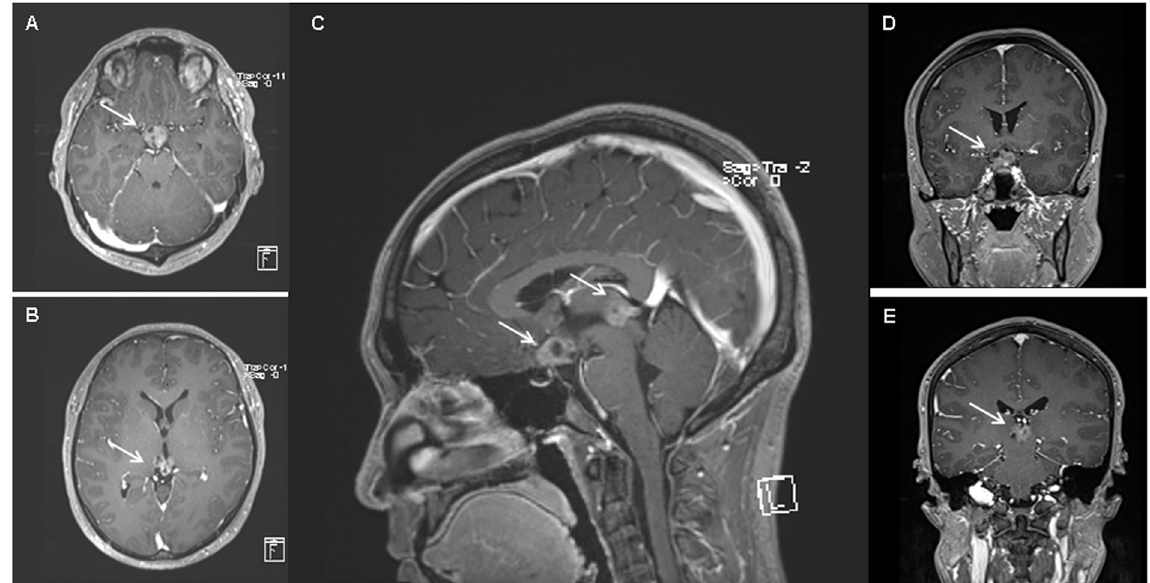
Fig 1. A case of bifocal germinoma at diagnosis. (a) Suprasellar lesion (white arrow) on MRI T1 gadolinium axial image. (b) Pineal lesion (white arrow) on MRI T1 gadolinium axial image. (c) Bifocal lesions (white arrows) on MRI T1 gadolinium sagittal image. (d) Suprasellar lesion (white arrow) on MRI T1 gadolinium coronal image; E) Pineal lesion (white arrow) on MRI T1 gadolinium coronal image.